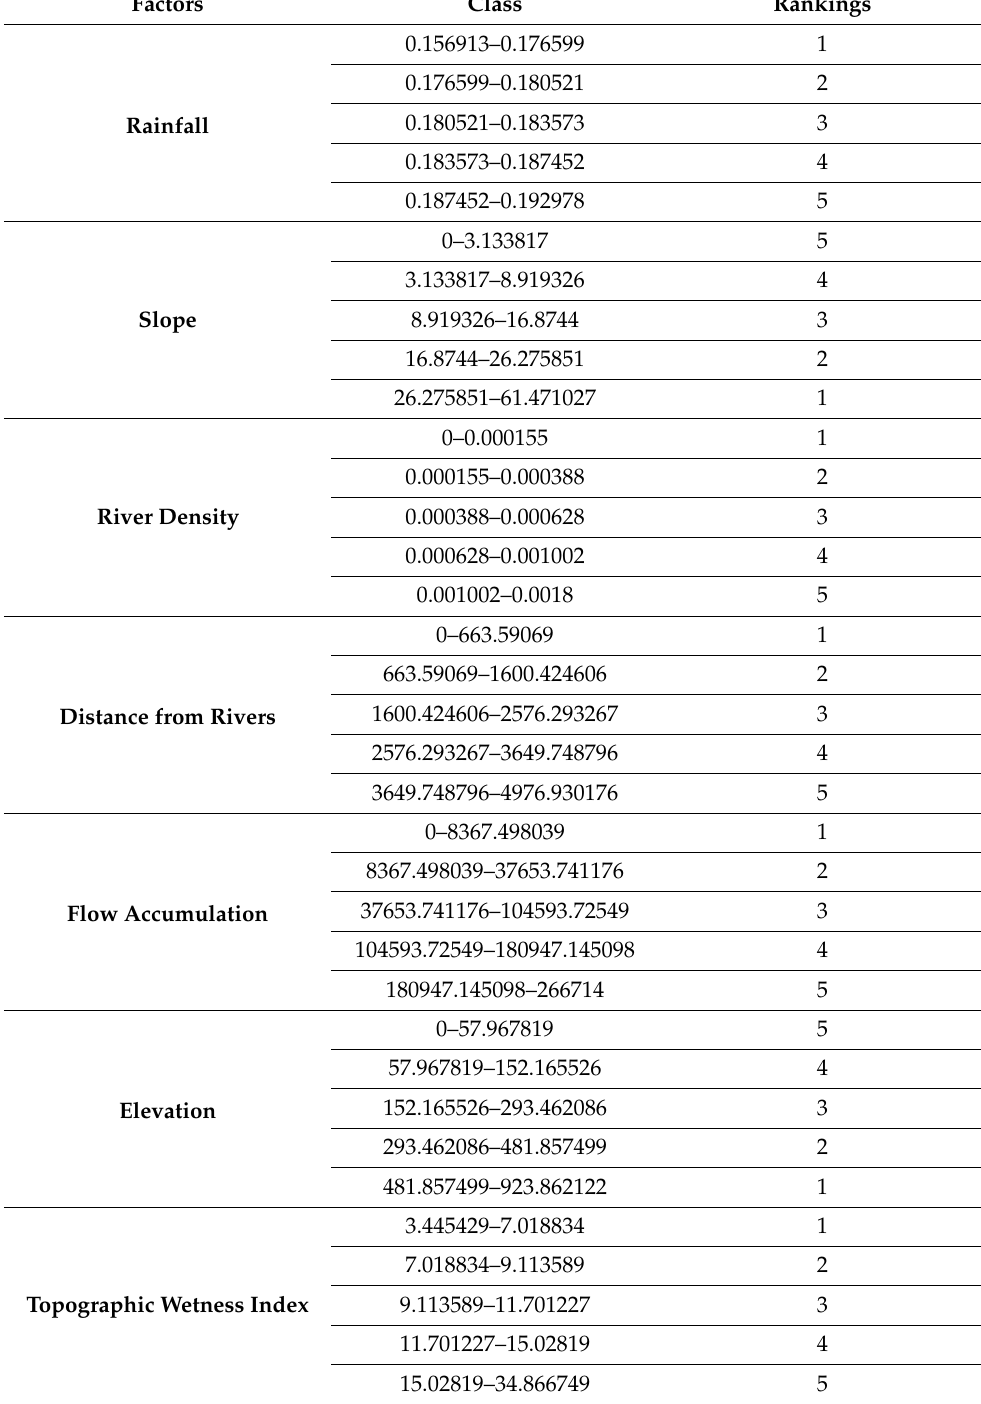
Table 2. Classes of conditioning factors and